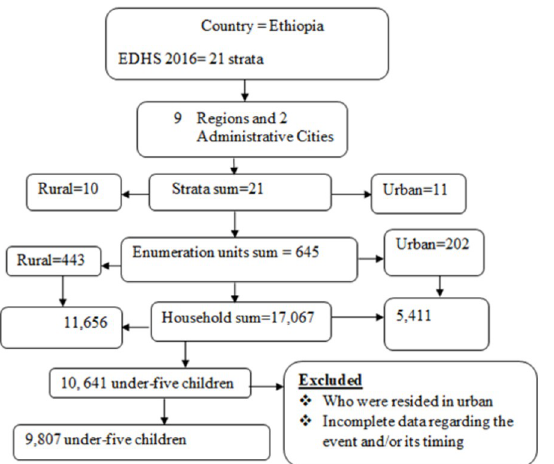
Fig 1. Sample size and schematic presentation of the sampling procedure for time to under-five mortality and its predictors in rural Ethiopia.